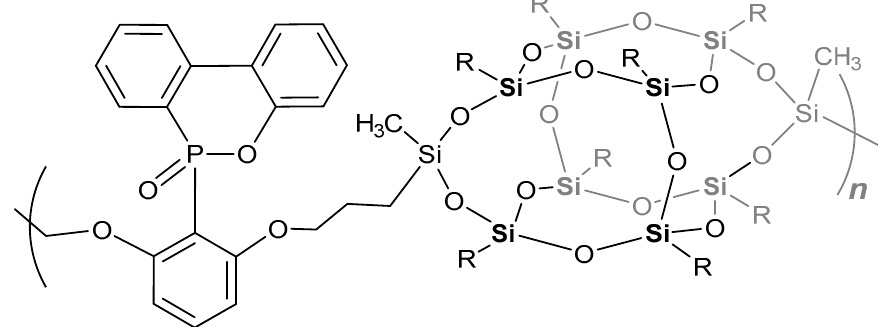
Figure 10. A copolymer containing DOPO flame retardant and DDSQ